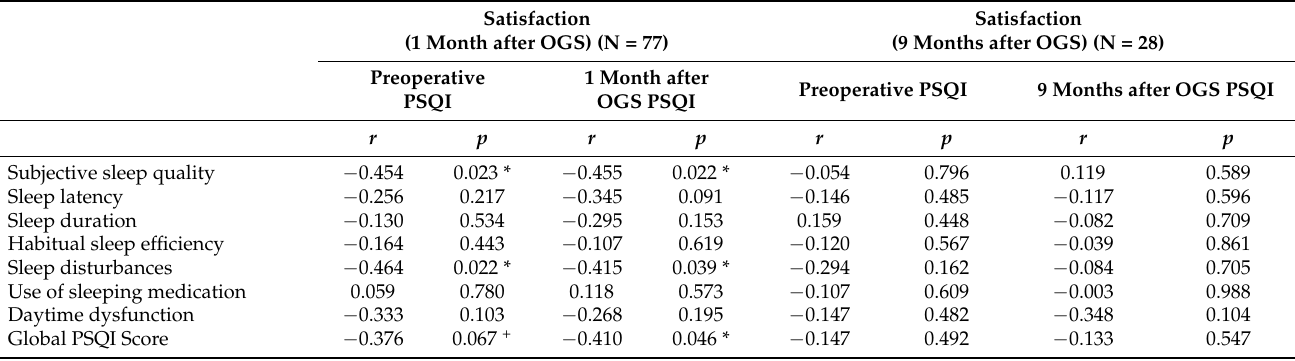
one month after OGS, as well as one-month postoperative global PSQI score ( r = − 0.410, p = 0.046) (Table 4). We observed no significant correlation between PSQI and satisfaction nine months after OGS, indicating that sleep problems negatively correlated only with short-term satisfaction. Table 4. Correlation between the PSQI (preoperative, 1 month and 9 months after OGS) and surgical